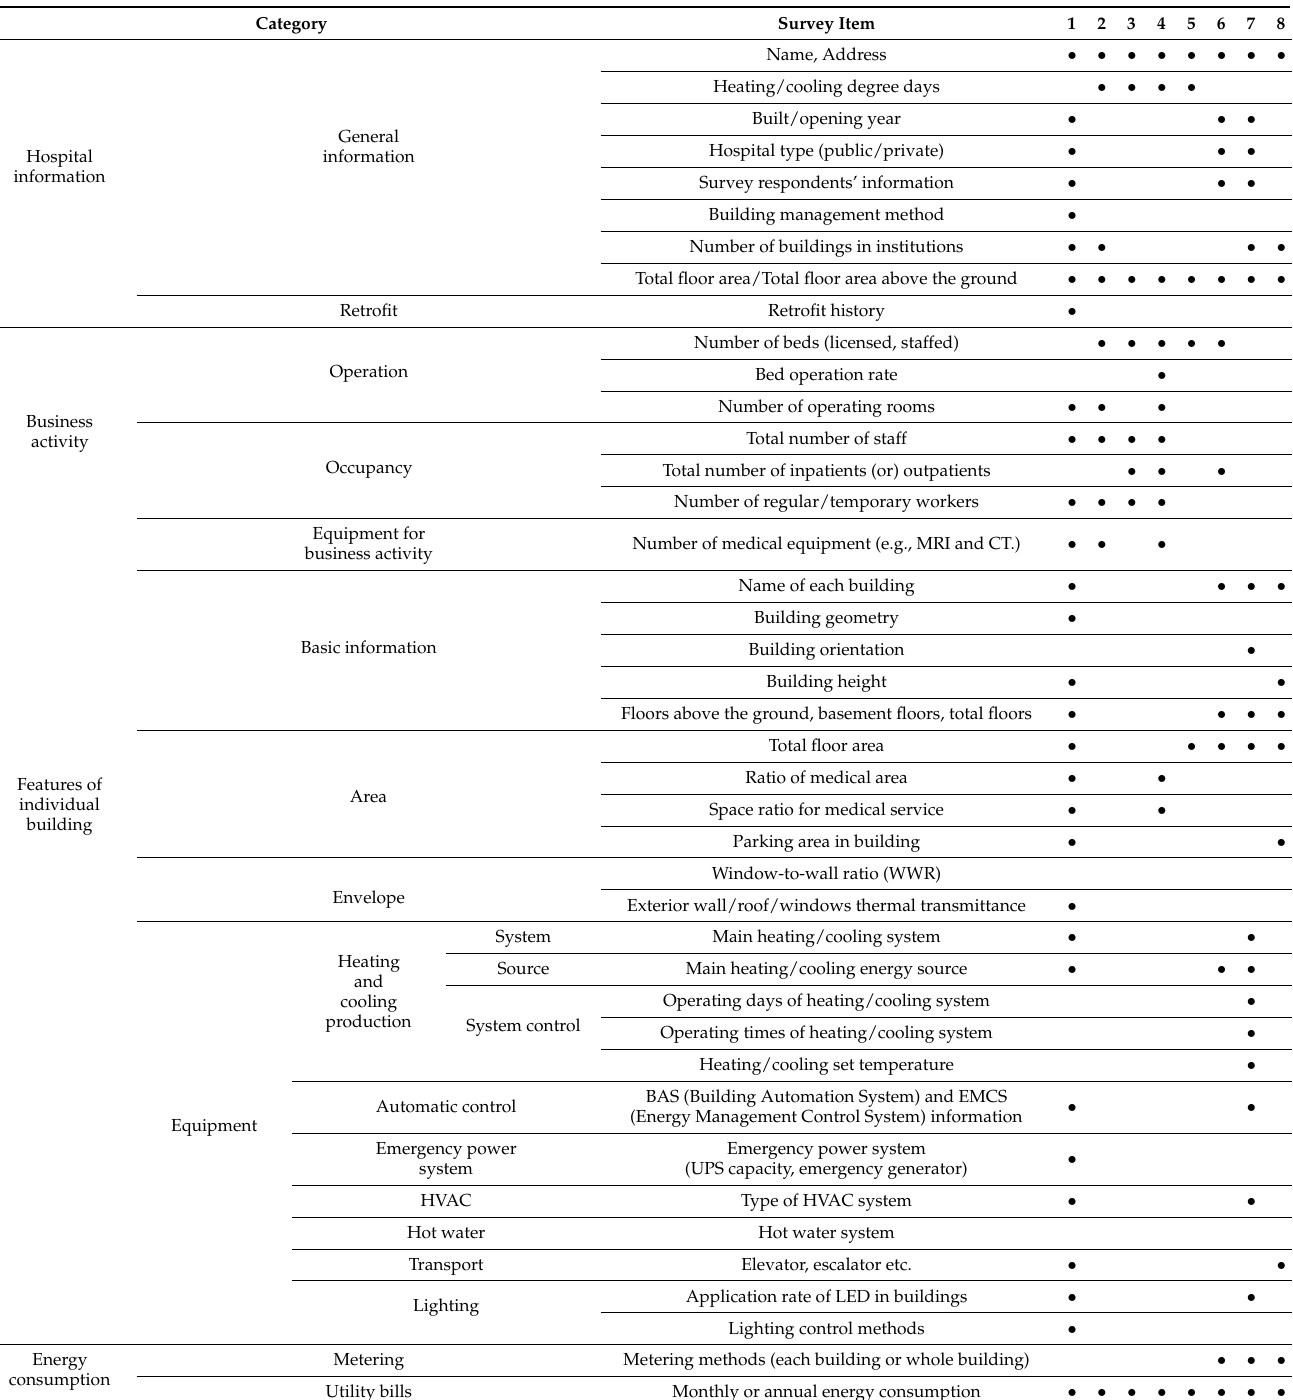
Table 2. Survey items and the utilization of each